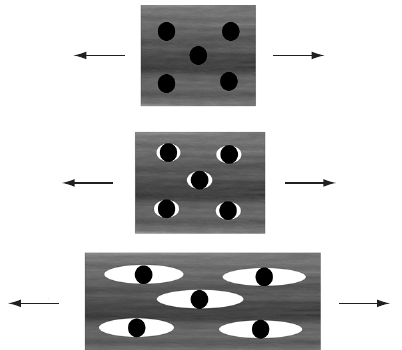
Figure 1. Toughening mechanism with rigid particles. Adapted from Refer- ence number